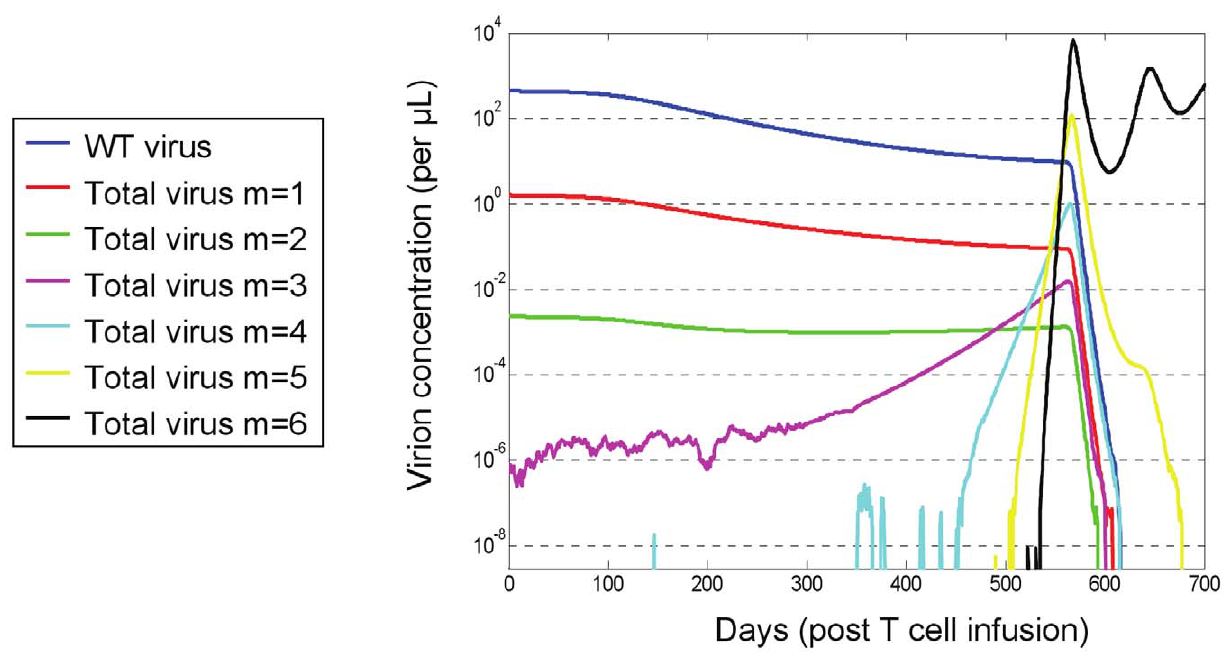
Figure 3. Dynamics of resistance evolution in a typical hybrid stochastic-deterministic simulation. Following T cell infusion, a decline in wild-type (WT) virus and pre-existing mutants is accompanied by the emergence of fitter and highly resistant mutants. Mutant strains are aggregated according to the number of resistance mutations they carry ( m ), which determines their resistance phenotype. Carrying more mutations renders a strain more resistant, with the most resistant strain carrying n =6 mutations. Stochastic effects are observed at very low densities, where advantageous mutations experience drifts before accumulating to critical levels which enable their consistent expansion. Populations whose density decreases below a pre-defined threshold ( 3 | 10 { 9 entities per m L) are considered extinct until they resurface. In this simulation, the total mutant density reaches WT density at approximately 550 days after infusion, marking the fixation of the resistant strain. Simulation was performed with default parameter values (see the Methods